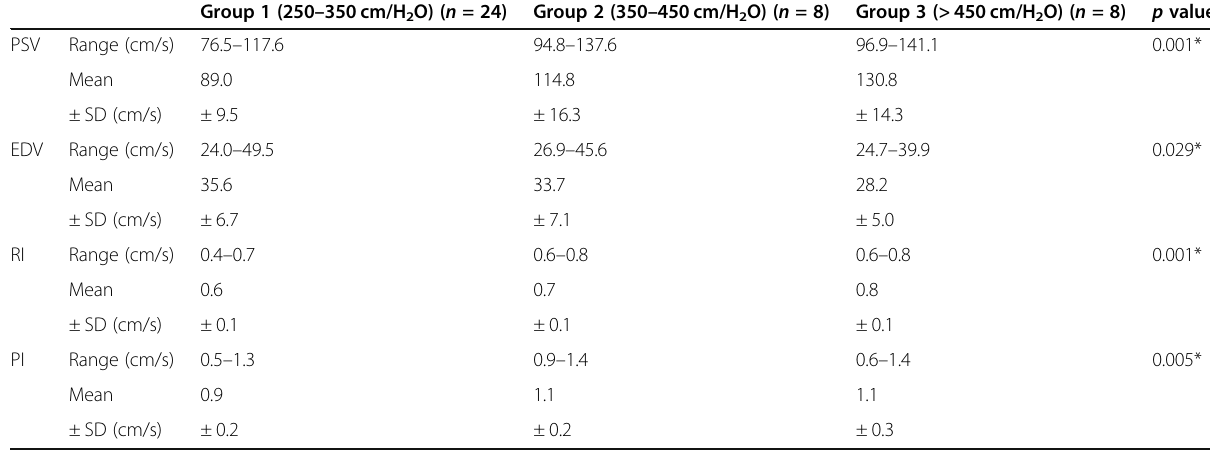
Table 3 Comparison between the 3 groups regarding TCD